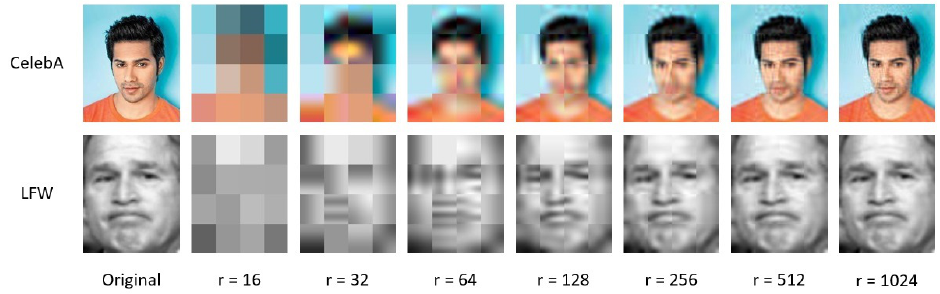
Figure 9. Sample image of the training set and variation of DCC with r